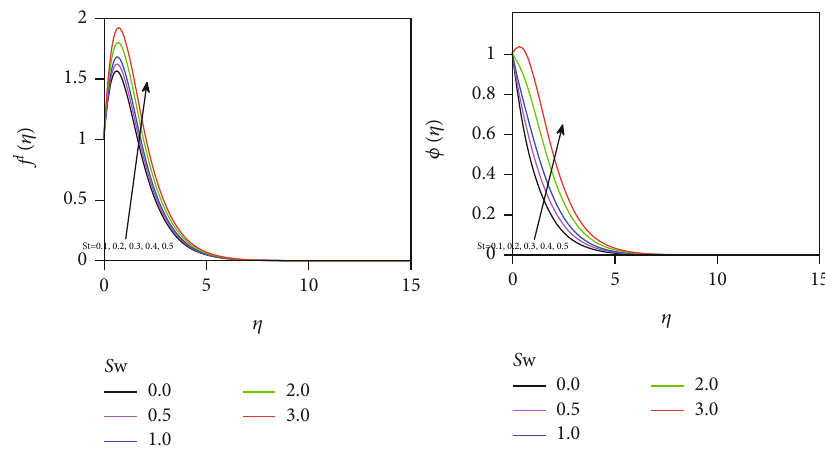
Figure 4: Signi fi cance of the suction and thermal strati fi cation on velocity and concentration plot.